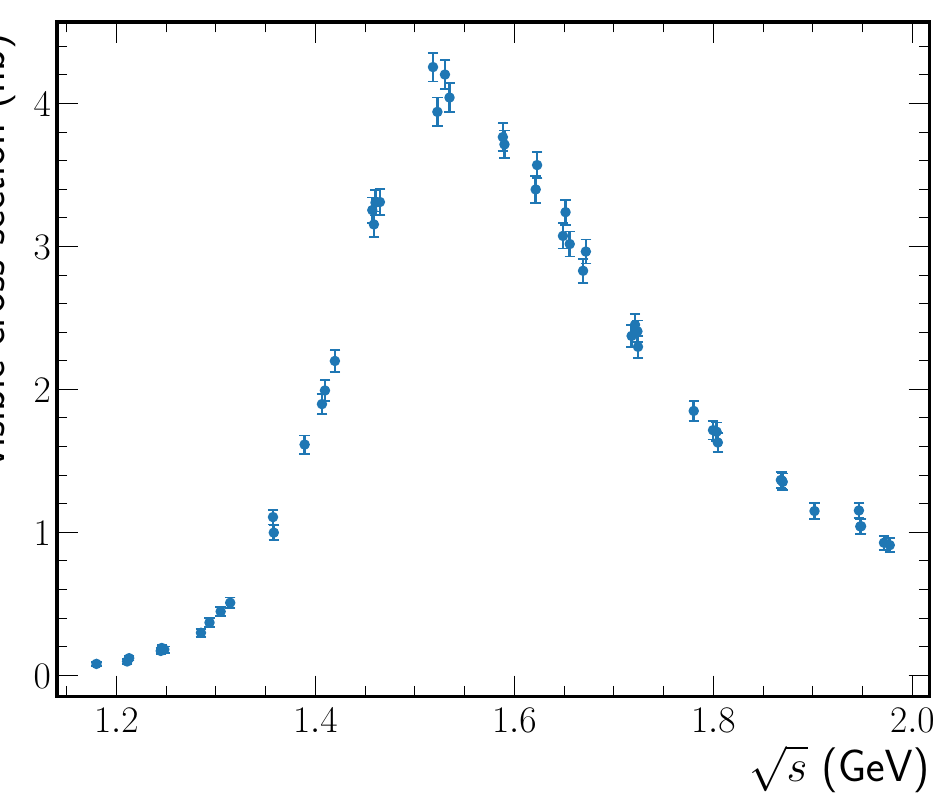
Figure 3. An example of the dependence of the e + e − → ηπ + π − visible cross section on the c.m. energy. The distribution of the c.m. energy points is highly non-uniform. The cross section shown in the figure is not the result of an experiment. The cross section points are generated randomly using the vector meson dominance